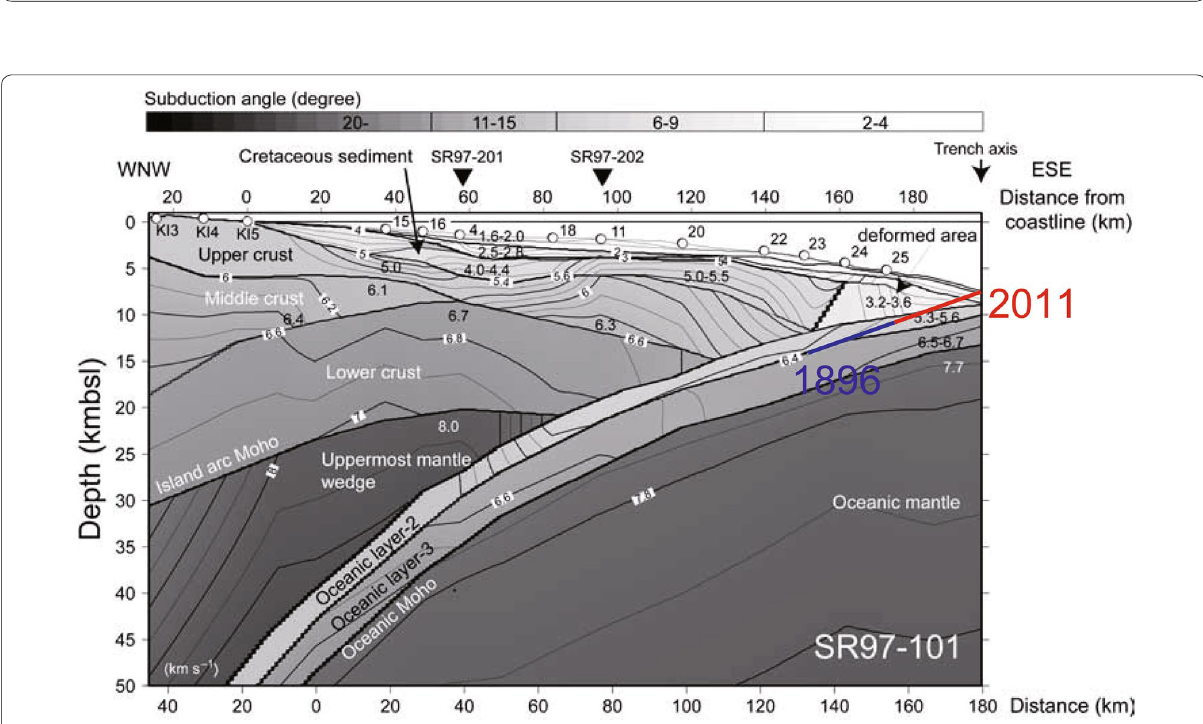
Fig. 5 Cumulative slips on subfaults of the 2011 (red columns) and 1896 (blue) earthquakes. The main slip was on the shallowest subfaults in 2011 (Satake et al. 2013b), while it was on the deeper subfaults in 1896